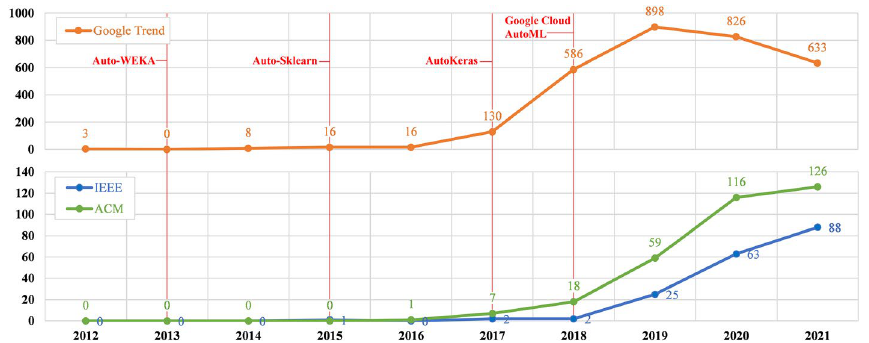
Fig. 1 The rising trend of AutoML in Google Trend (worldwide), IEEE Xplore, and ACM Digital Library during 2012 to 2021. The vertical axis represents the numbers of search results according to the “AutoML” search keyword in each year. Note that values plotted in this figure were manually collected from each search engine on December 15, 2021, without any coding or scraping software